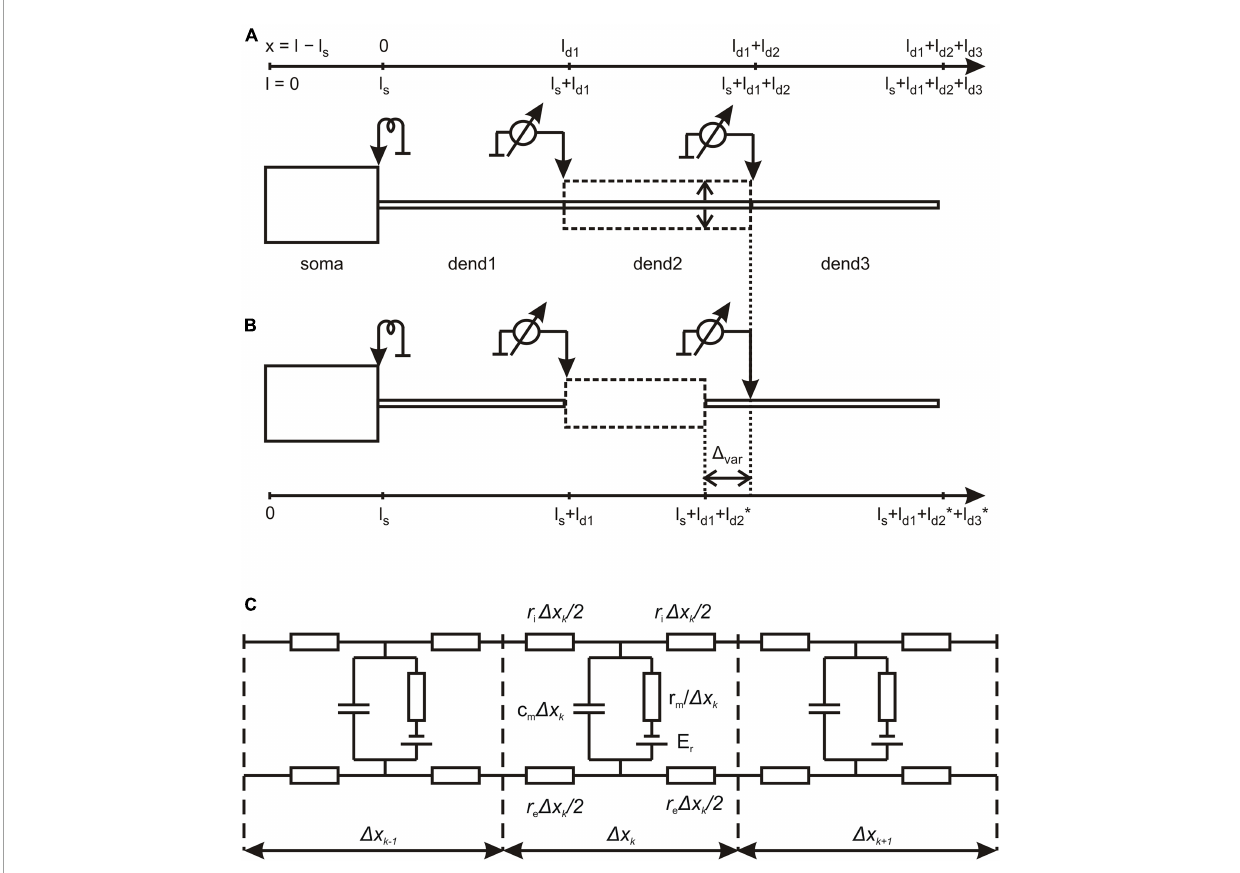
FIGURE1 Structure of magnocellular neurosecretory neurons (MNN) models. (A) The reference configuration with dendritic compartments dend1, dend2, and dend3 of equal lengths and stem diameter (solid lines); dashed line indicates variation of dend2 diameter representing the varicosity. (B) The configuration, in which the varicose compartment dend2 has a varying length and the distal compartment dend3 has a co-varying length so that the total length of the three-compartment dendrite remains unchanged (see also Table 1 ). (C) The lamped equivalent electric circuit of dendritic cable with parameters per unit path length. Detailed explanations are given in the text.